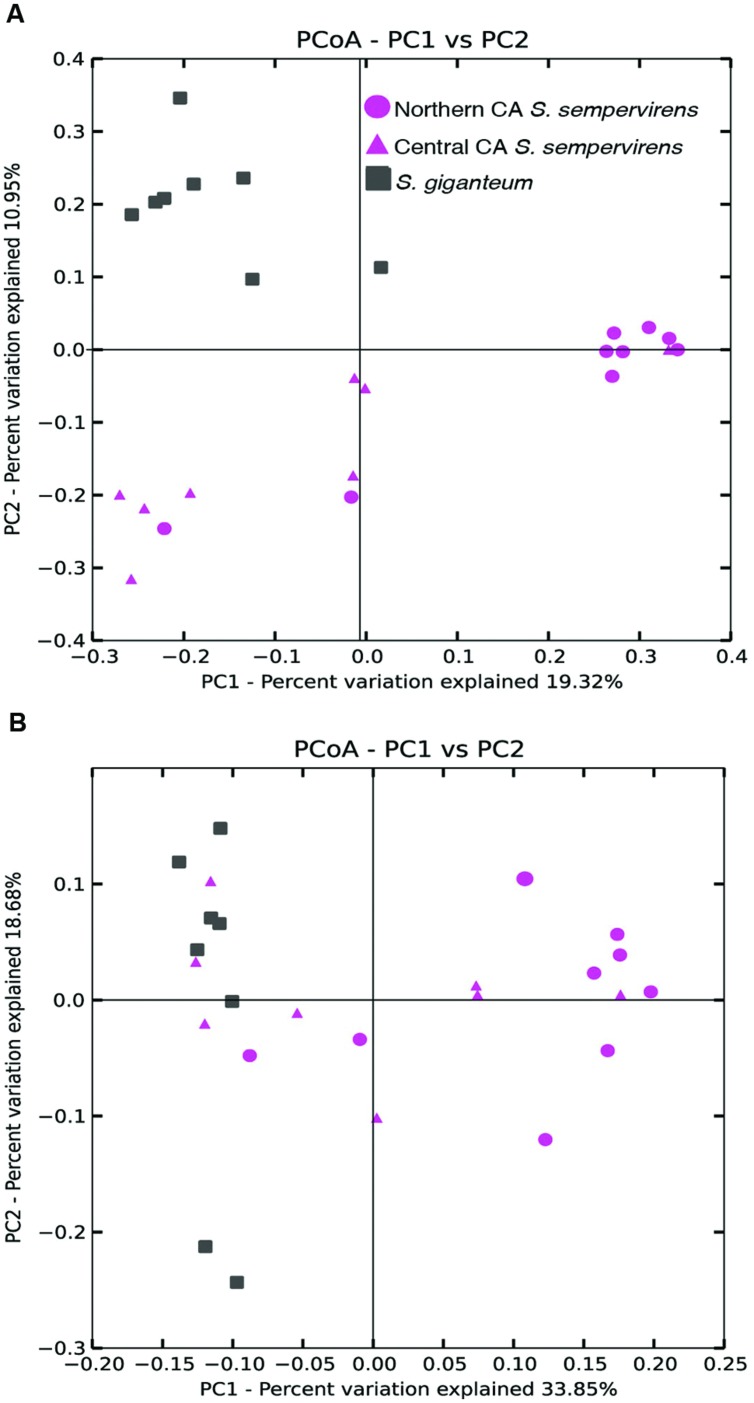
Principal coordinate analysis (PCoA) of the (A) unweighted and (B) weighted UniFrac distance matrices. Points that are closer together on the ordination have communities that are more similar. Each point corresponds to a sample, and shapes correspond to host tree populations. Coast redwood (CR) samples are shown in pink, and giant sequoia (GS) samples are shown in gray.